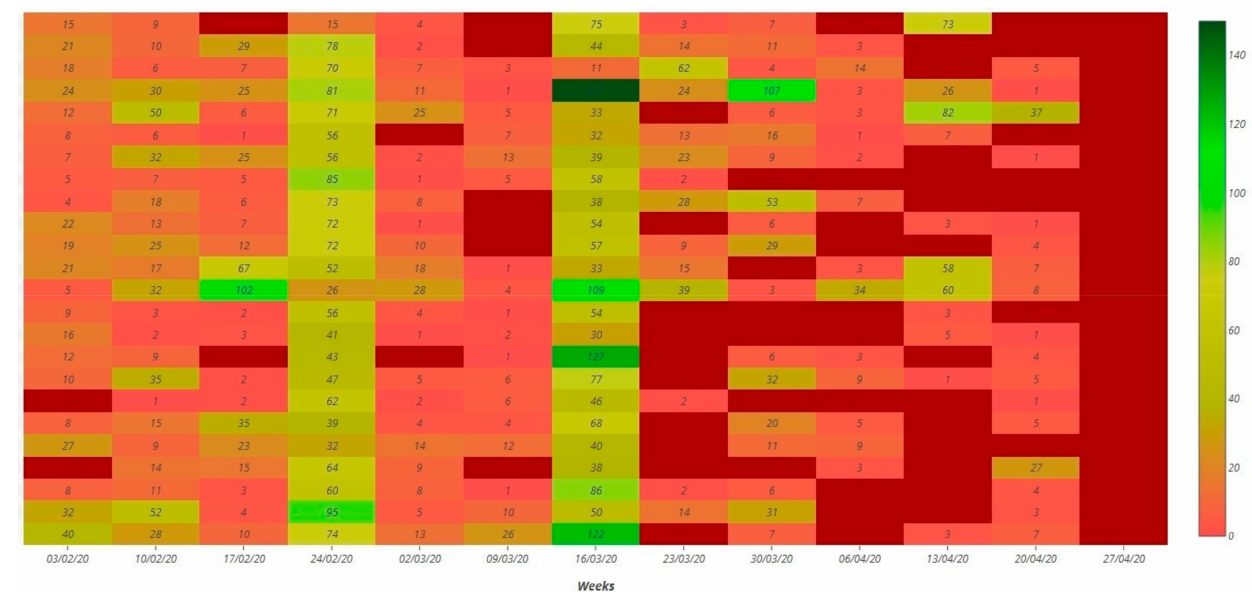
Figure 1. Heat map of weekly student monitoring in Moodle using UBUMonitor